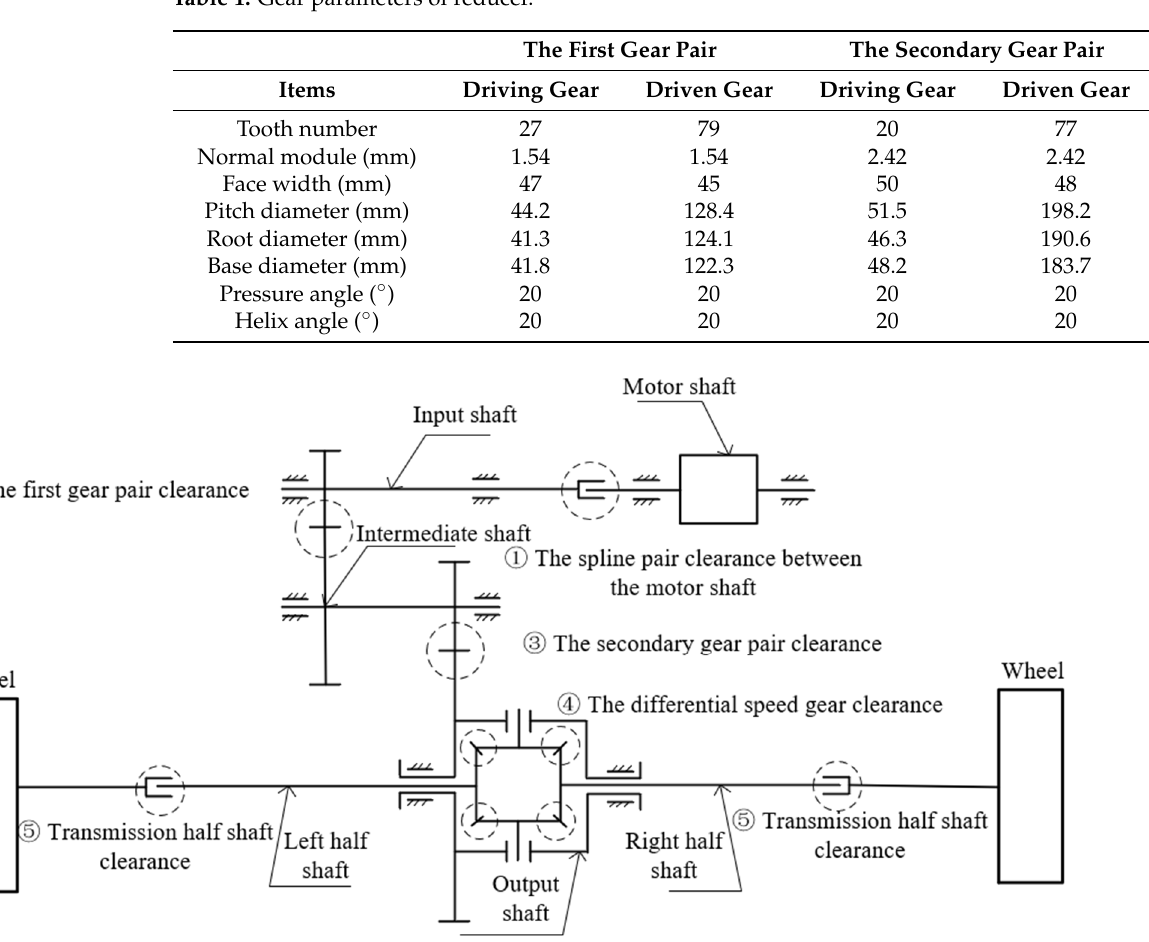
Table 1. Gear parameters of reducer.